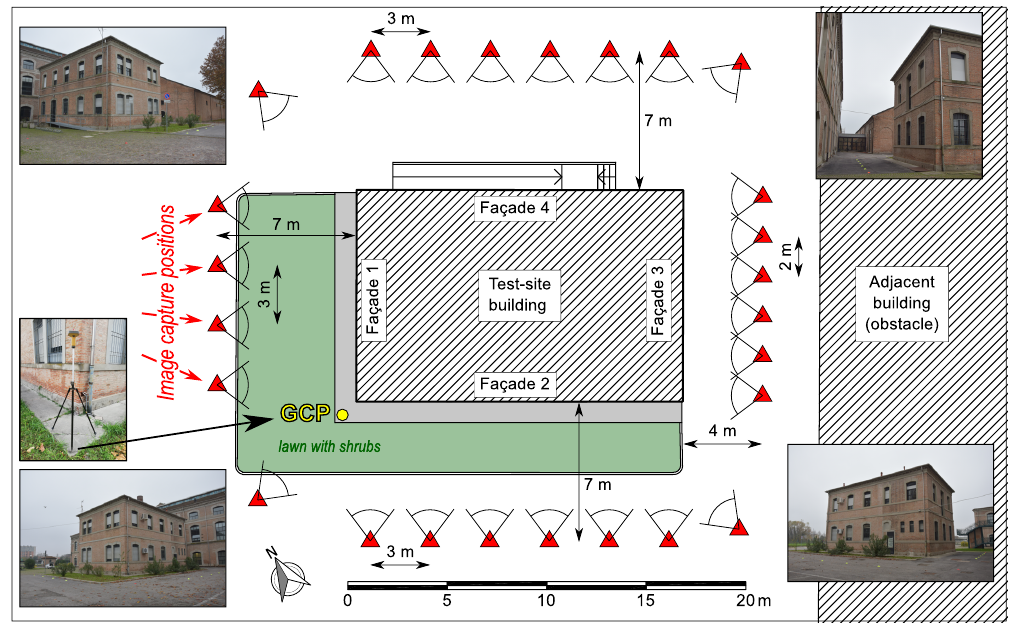
Figure 5. Planning of Unmanned Aerial Vehicle (UAV) image acquisition of the test-site building. Pictures shown in this figure were captured at each building corner during flight